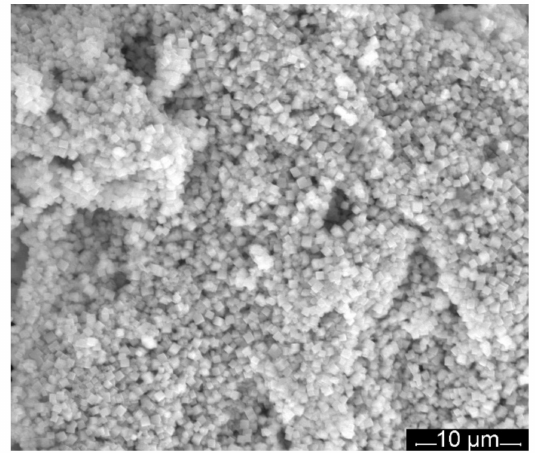
Figure 3. SEM micrographs of MnTa 2 O 6